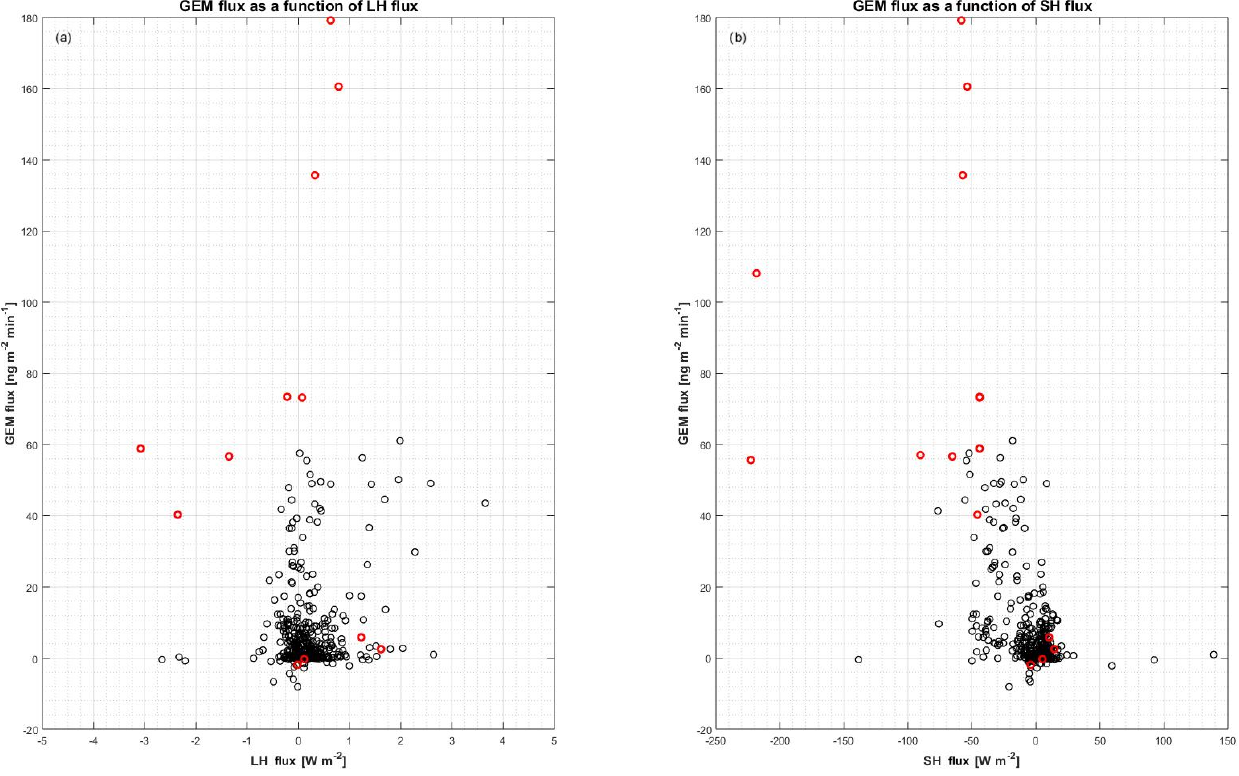
Figure 11. Relation between GEM flux and heat flux. (a) GEM flux in ngm − 2 min − 1 as a function of latent heat flux in Wm − 2 , and (b) GEM flux in ngm − 2 min − 1 as a function of sensible heat flux in Wm − 2 . The red circles are data from the period starting on 30 April, which are considered as outliers (see the text for further